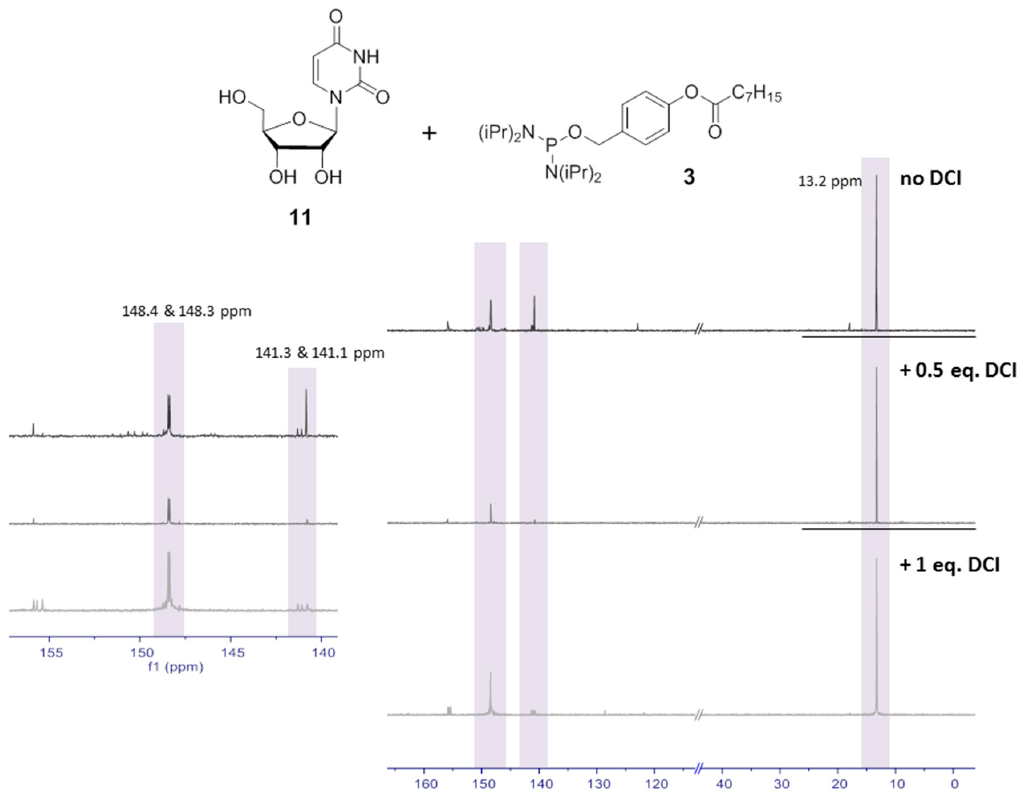
Figure 2. 31 P-NMR spectra (CH 3 CN-d 3 , 162 MHz, 25 °C, shifts δ in ppm) of the reaction monitoring between uridine 11 and OBPA 2 3 .